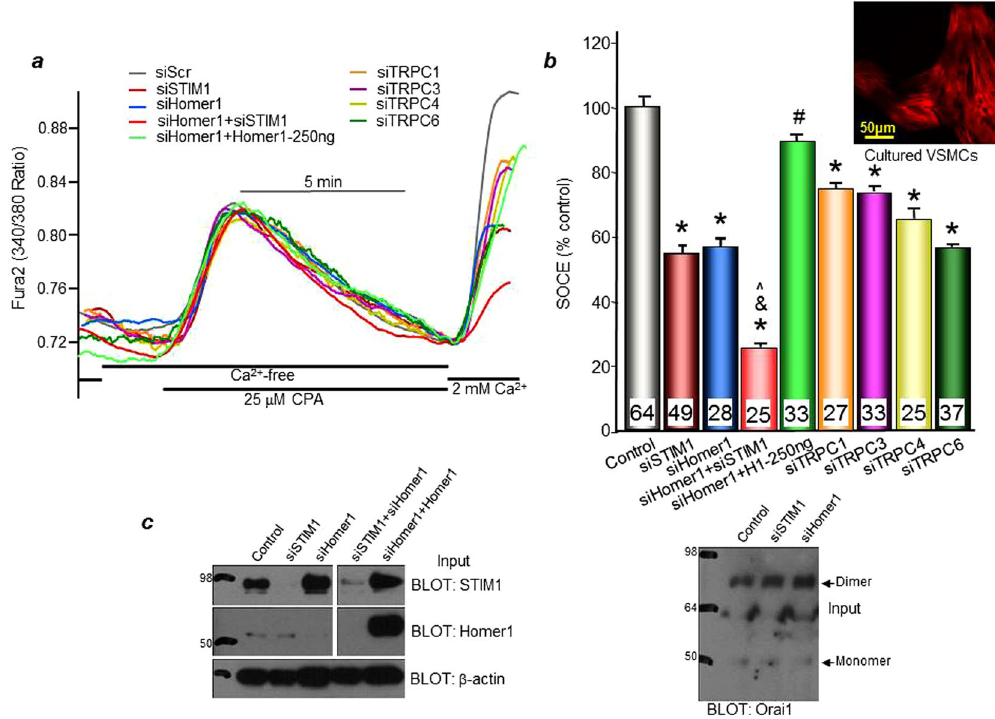
Figure 3. Effect of Homer1 knockdown on store-operated Ca 2 + entry (SOCE) in cultured VSMCs. Cultured aortic VSMCs (1 × 10 5 ) were transfected with various siRNAs and 250 ng/mL of Homer1 cDNA, as indicated, and SOCE was measured after depleting ER Ca 2 + stores with 25 μ M cyclopiazonic acid (CPA). ( a ) Representative Ca 2 + traces vs. time. ( b ) SiHomer1, siSTIM1, siHomer1 + siSTIM1, siTRPC1, siTRPC3, siTRPC4, and siTRPC6 all significantly reduce SOCE in cultured VSMCs. Knockdown of both Homer1 and STIM1 further inhibits SOCE and, thus, has an additive effect on Ca 2 + influx. By contrast, Homer1 overexpression rescues inhibition of SOCE by siHomer1. SOCE values are normalized to peak Ca 2 + store depletion (CPA response) and indicated as % control (scrambled siRNA), which is set to 100%. * p < 0.01 compared to control; # p < 0.01 compared to siHomer1; ^ p < 0.01 compared to siSTIM1; & p < 0.01 compared to siHomer1. Representative VSMCs stained with β -actin (red) are shown (inset). ( c ) Protein expression levels of native Homer1 and STIM1 are reduced in cells treated with their respective siRNAs, while Homer1 overexpression is robust with no effect of siHomer1. Spliced images come from the corresponding same blot, but are not neighboring